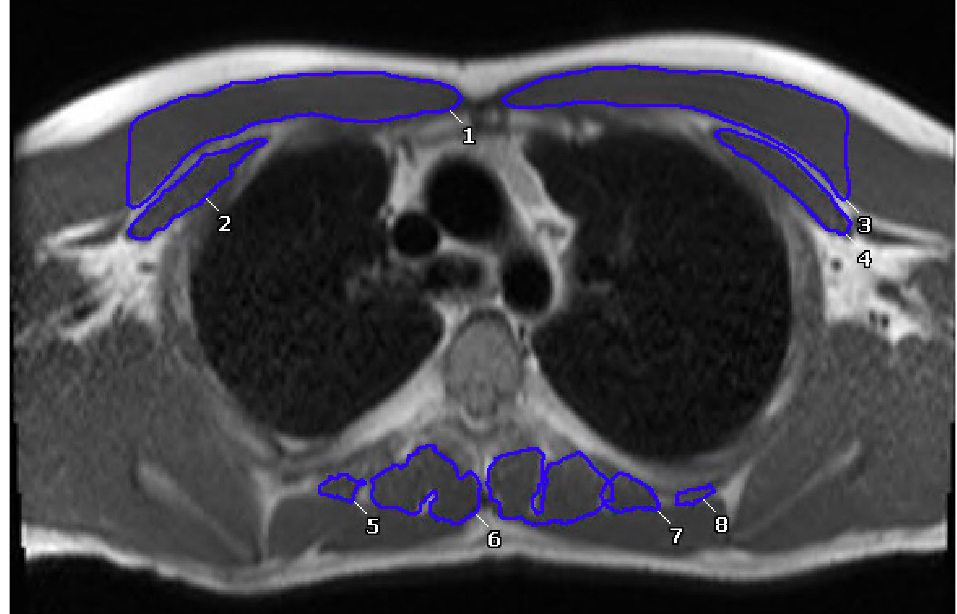
Figure 1. Segmentation of anterior and posterior paraspinal muscles at the level of the carina. Numbers seen on scan signify different hand traced muscles to quantify total muscle area of anterior and posterior muscles.